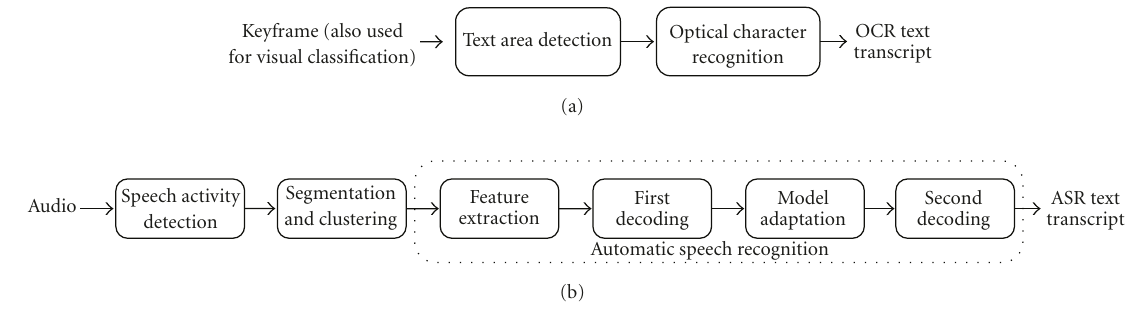
Figure 5: Overview of (a) visual analysis for text extraction and (b) audio analysis. Both result in the generation of text transcripts.